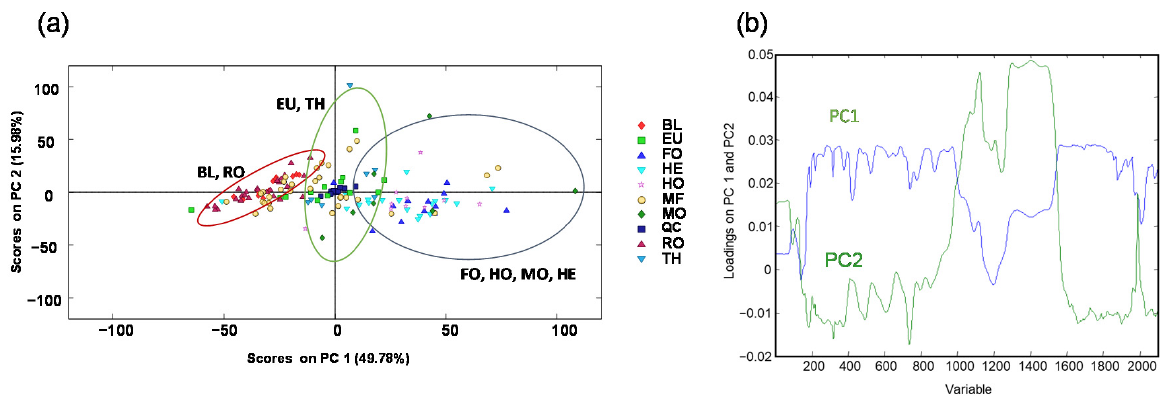
Figure 2. PCA score plot of PC1 vs. PC2 ( a ) and plot of loadings of PC1 and PC2 ( b ) when using non-targeted HPLC-UV chromatographic fingerprints (at 280 nm) as honey chemical descriptors. BL: Orange/lemon blossom; EU: Eucalyptus; FO: Forest; HE: Heather; HO: Holm oak; MF: Multifloral; MO: Mountain; RO: Rosemary; TH: Thyme.